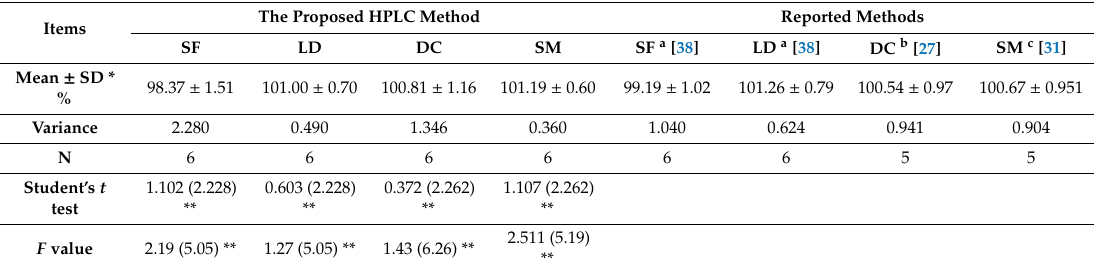
Table 6. Statistical comparison between results of the dosage forms of the proposed and those of the reported